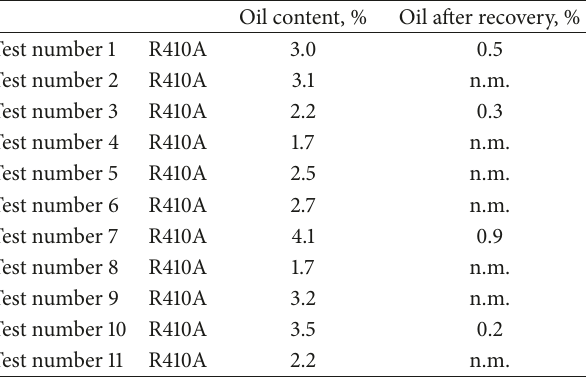
Table 2: R410A refrigerant gas analysis before and after